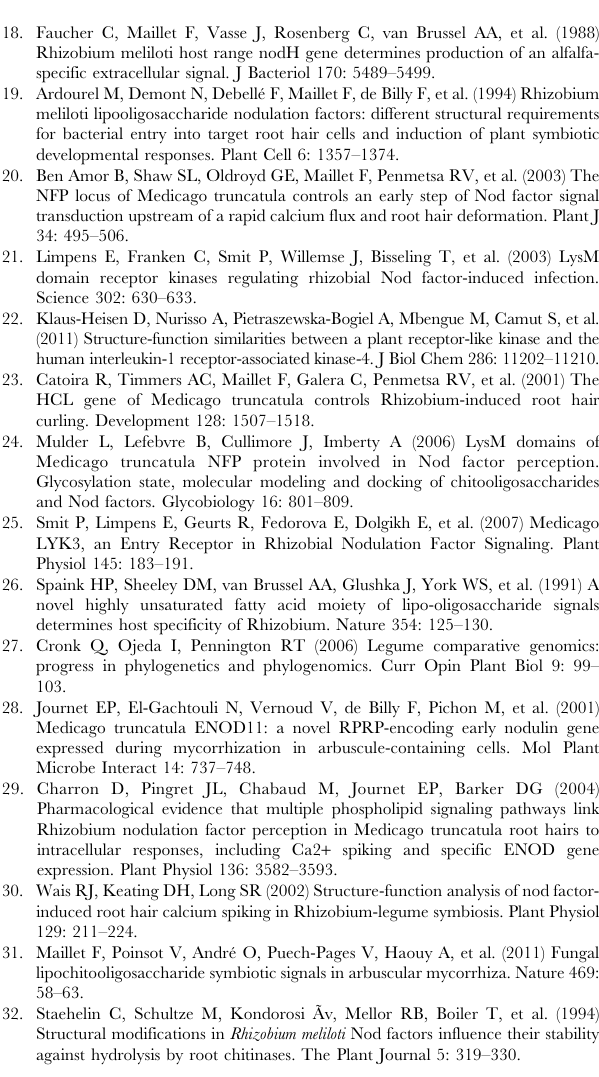
Figure S4 Complementation for pMtENOD11:GUS and nodulation of nfp plants by different chimeric constructs